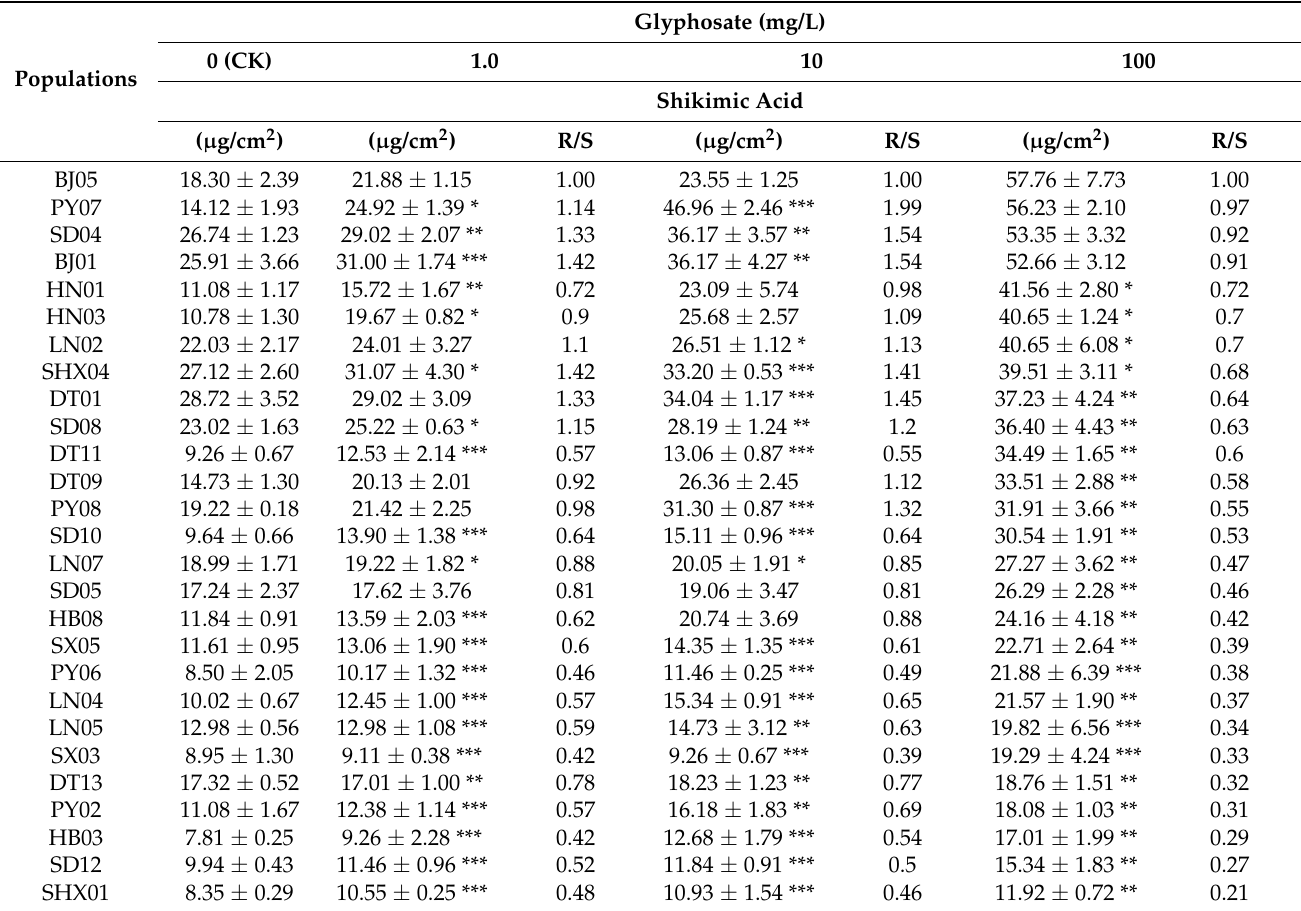
Table 1. Shikimate accumulation in E. indica leaves treated by glyphosate at concentrations of 1.0, 10 and 100 mg/L. Data were sorted from largest to smallest according the shikimic acid concentra- tion treated by 100 mg/L glyphosate.